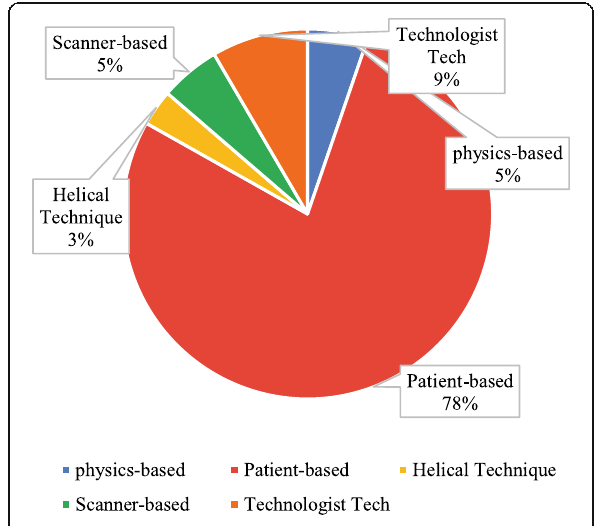
Fig. 7 The common sources of artifacts encountered in the department